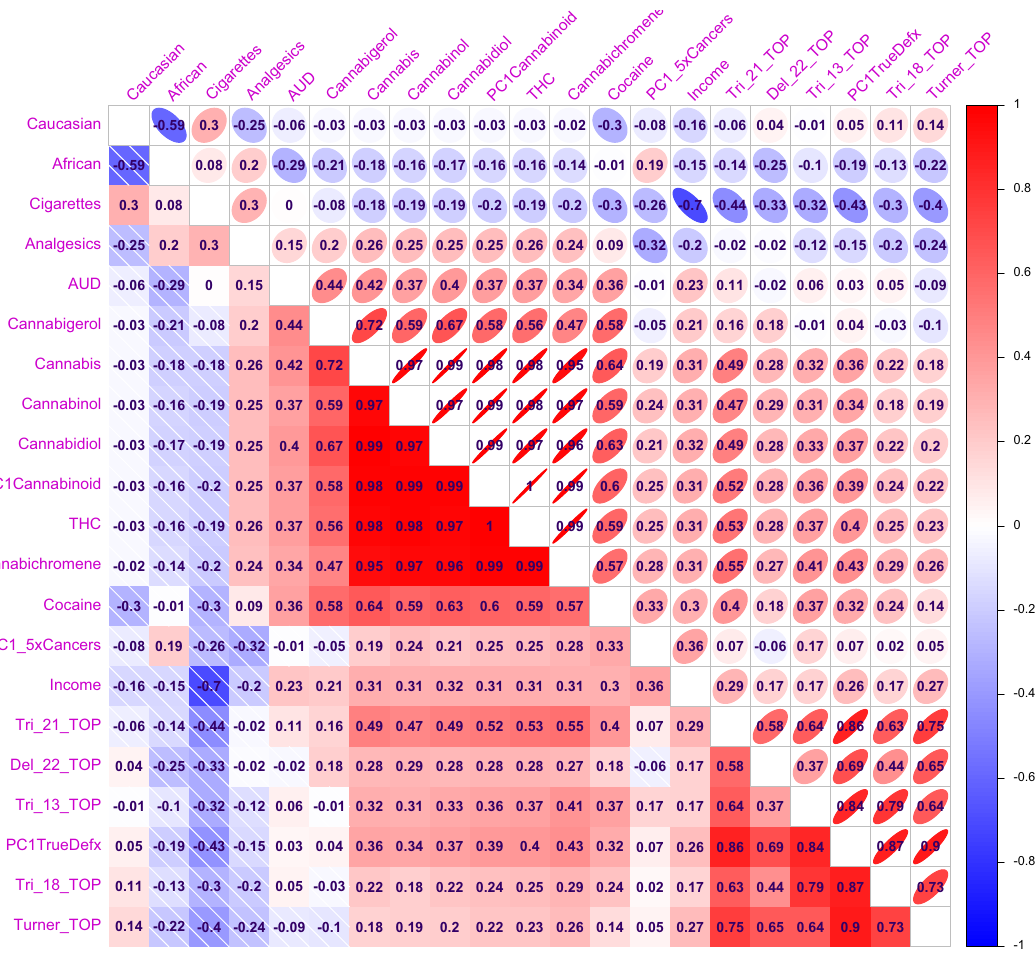
Figure 7. Correlogram drawn in Corrplot for the Pearson correlation coefficients between covariates for ETOPFA-corrected data. The colouring is scaled from strongly positive (bright red) to strongly negative (bright royal blue). The upper triangle represents these associations as ellipses where the width of the ellipses in inversely proportional to the strength of the correlation so that the strongest associations have the narrowest ellipses. Ellipses slope to the right for positive relationships and to the left for negative relationships. (Created in R-Studio version 1.3.1093 using corrplot version